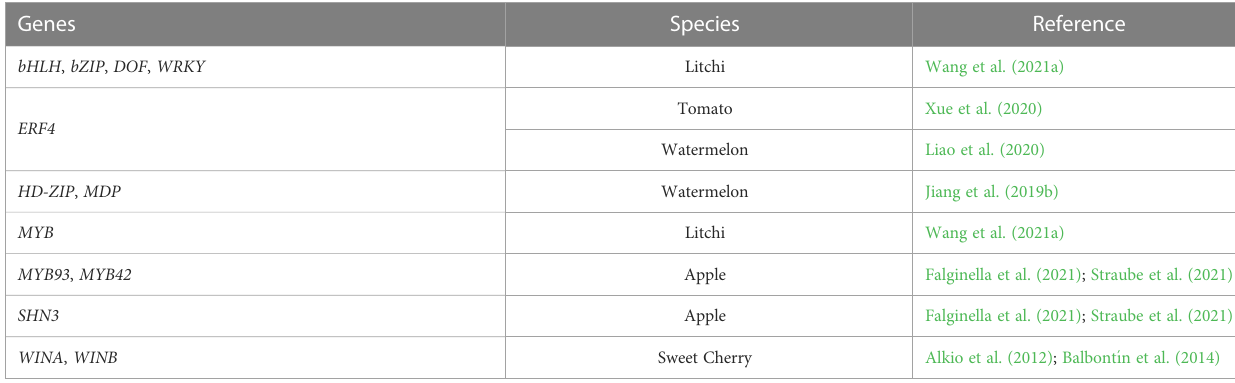
TABLE 6 Transcription factors genes potentially involved in fruit